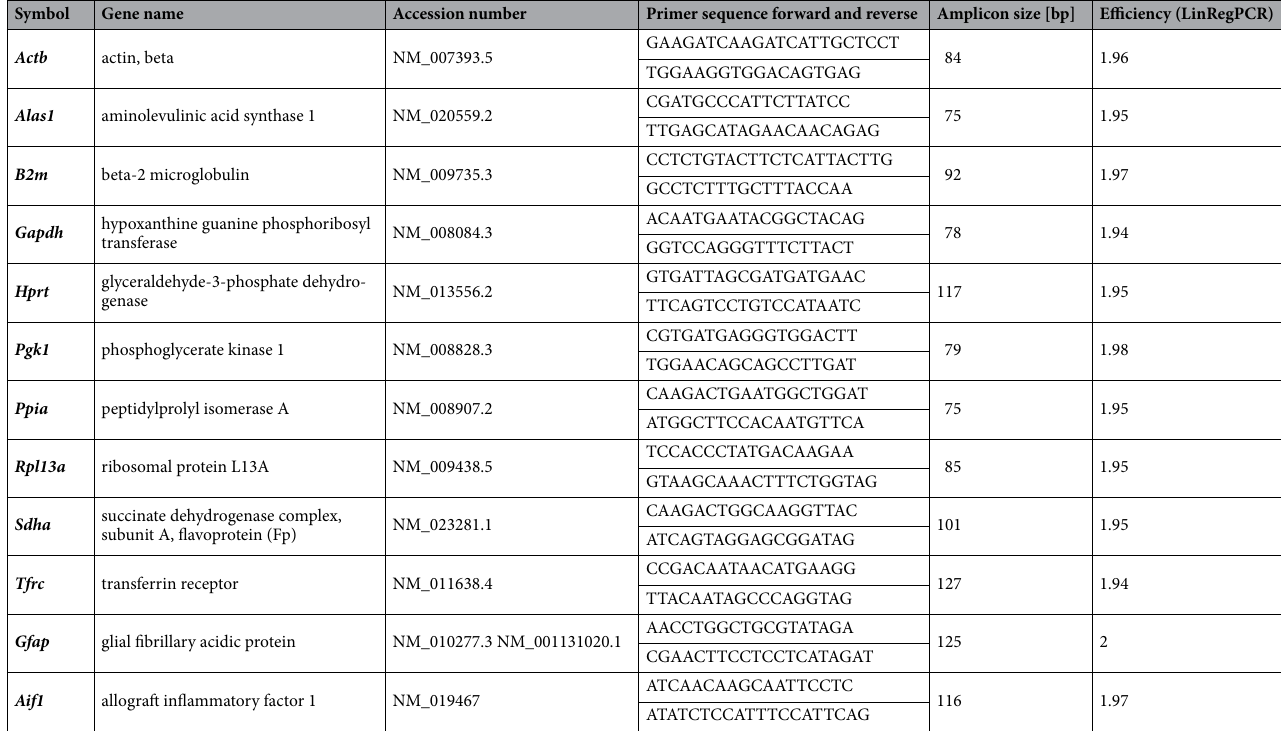
Table 3. Details of qPCR assays for candidate reference genes and target